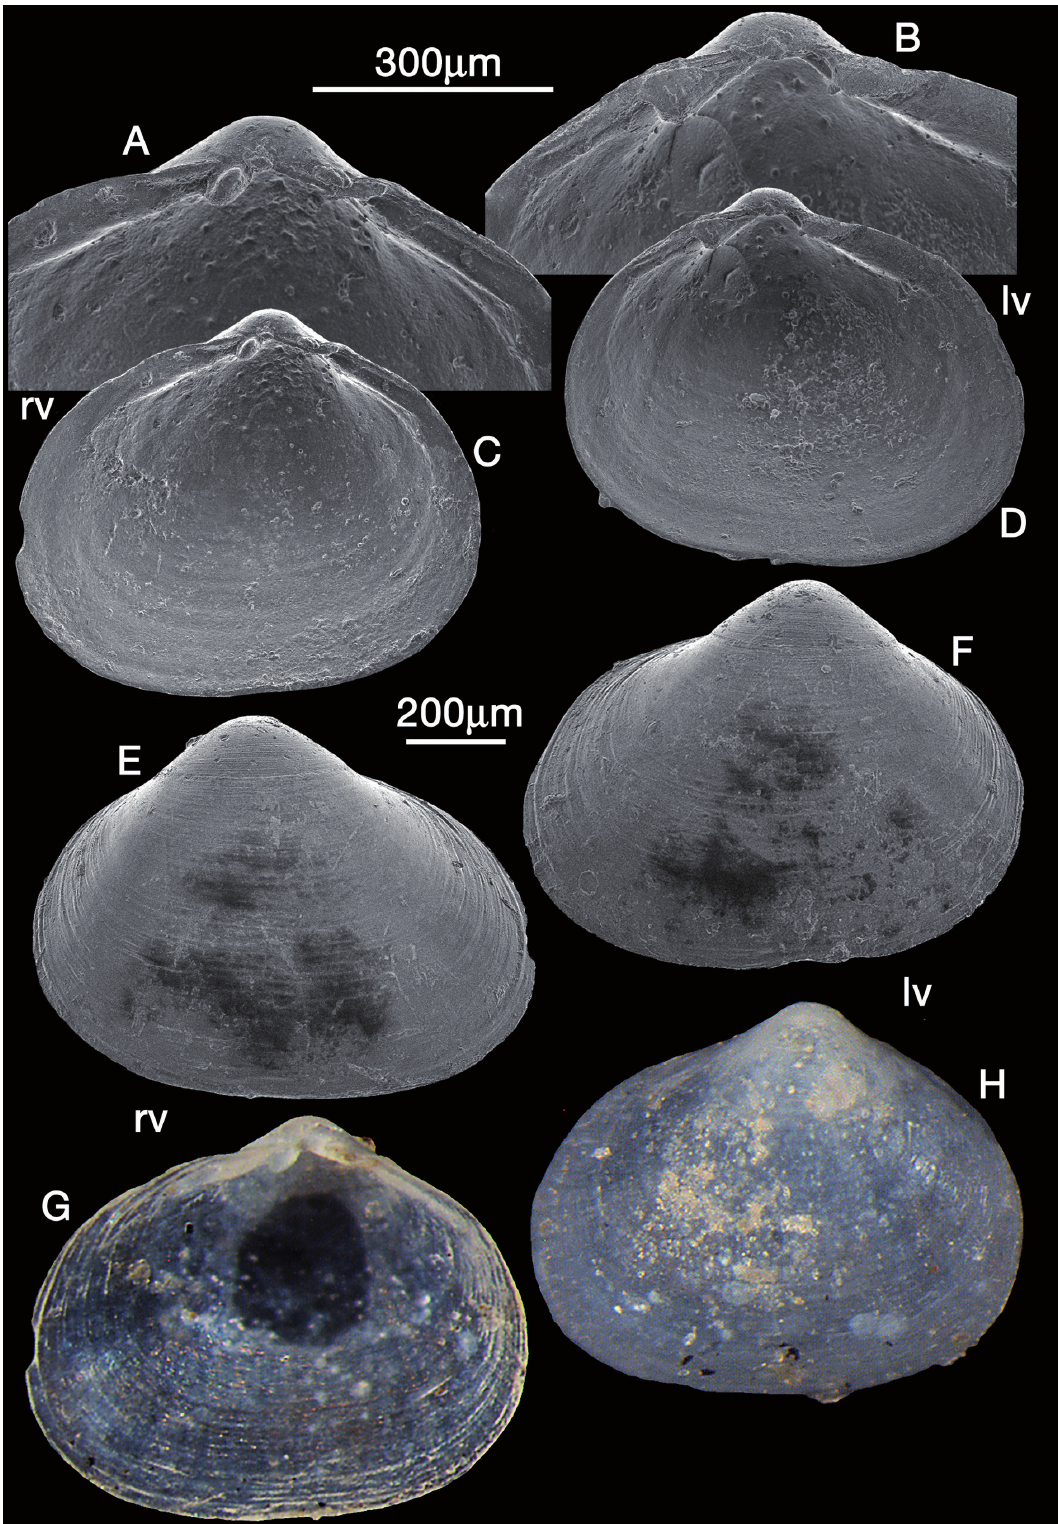
Fig. 2. Holotype of Kellia symmetros Jeffreys, 1876, USNM 170626. A-B . SEM of hinges of right and left valves. C-D . SEM of internal of right and left valves. E-F SEM of external of right and left valves. G-H . photo micrographs of internal and external of right